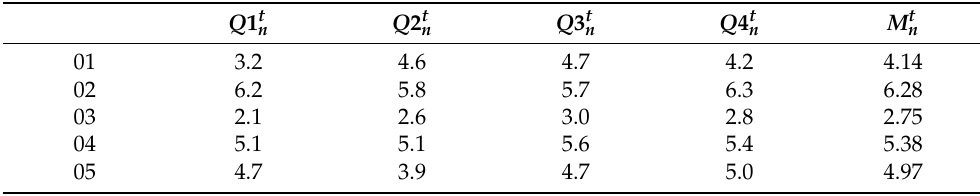
Table 4. The M t n and Li t n of some